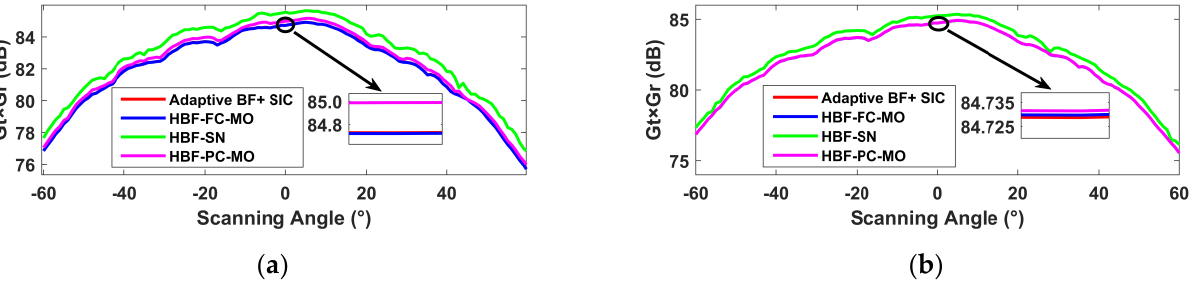
Figure 10. The system gain G t × G r of three categories of simplified structure and FD-ALSTAR ( a ) NRF = 2; ( b ) NRF = 24.